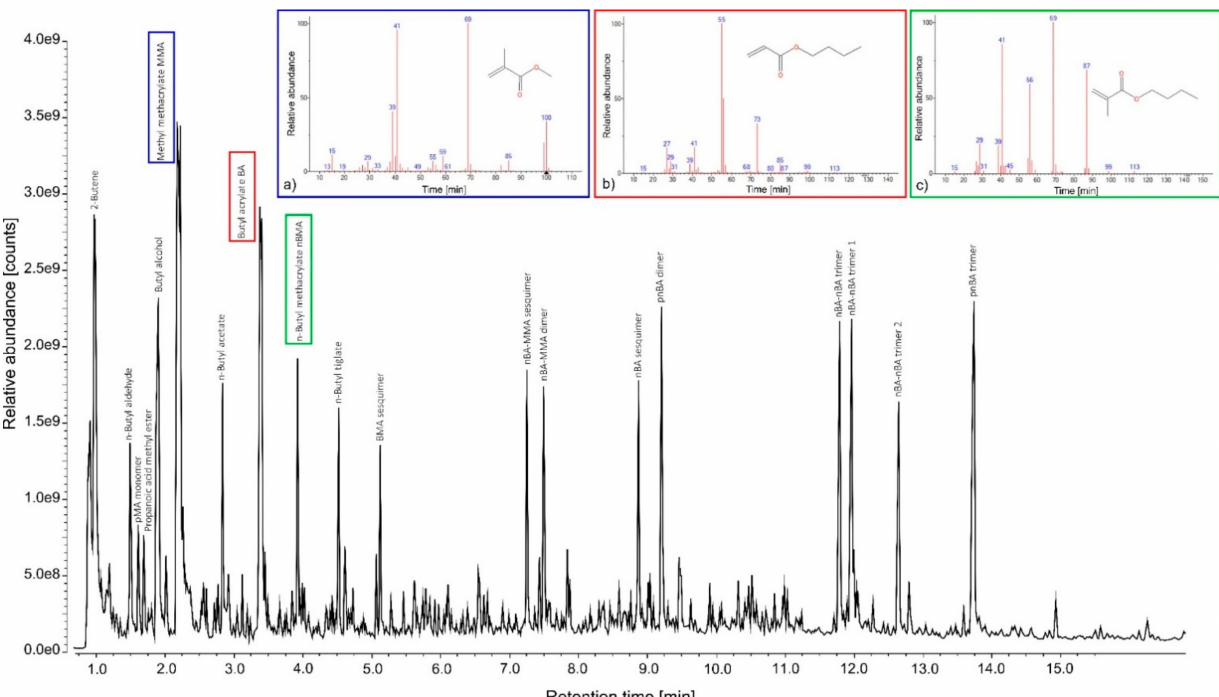
Figure 5. TIC (total ion current) pyrogram obtained after Py-GC/MS analysis of the pure unaged acrylic emulsion fragments. ( a ) Methyl methacrylate MMA; ( b ) Butyl acrylate BA; ( c ) n-Butyl methacrylate nBMA. Mass spectra of the highest intensity peaks detected are illustrated. All identified compounds are listed in Table